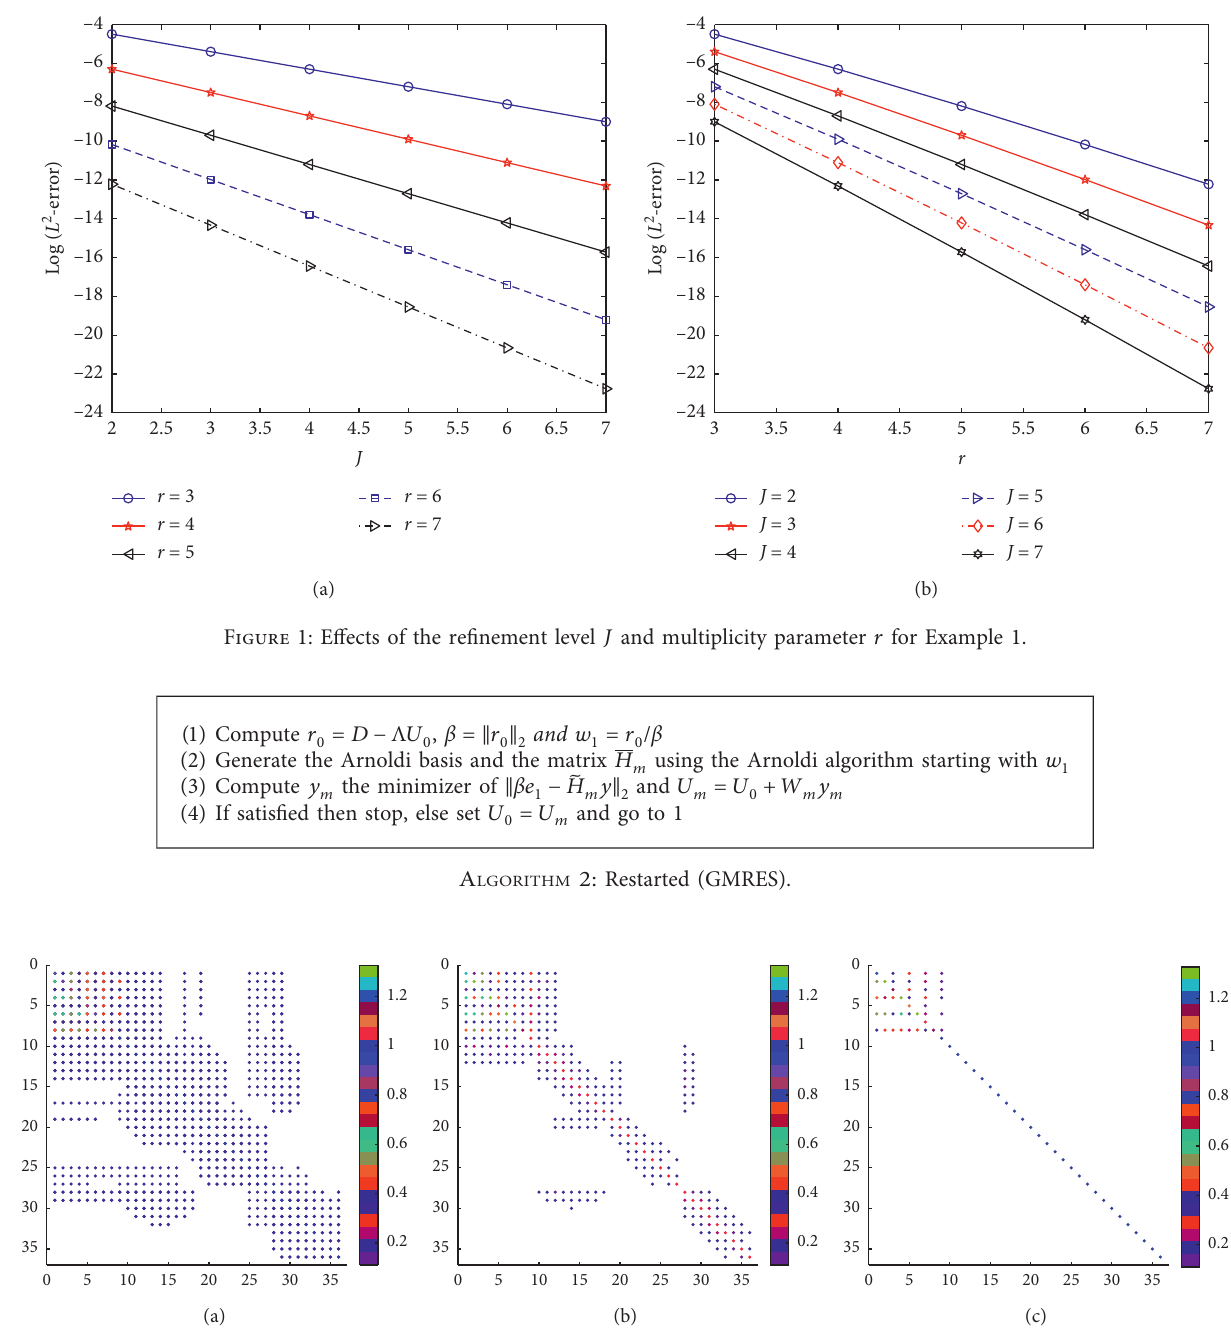
Figure 2: The effect of thresholding with threshold ε � 10 − 5 (left), ε � 10 − 3 (middle),and ε � 10 − 1 (right) onthe coefficient matrix for Example